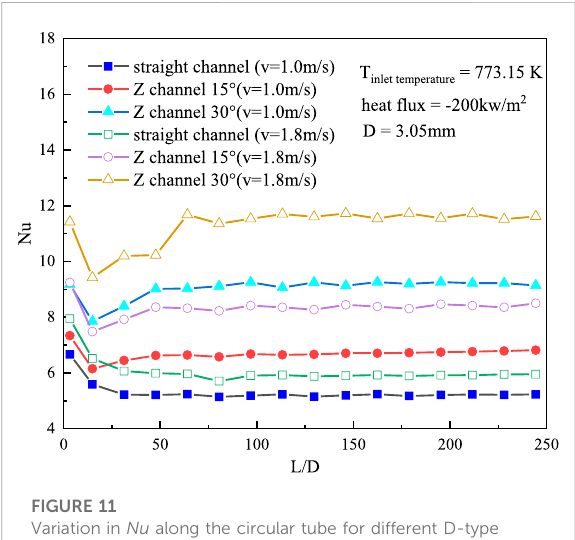
FIGURE 11 Variation in Nu along the circular tube for different D-type channels at different